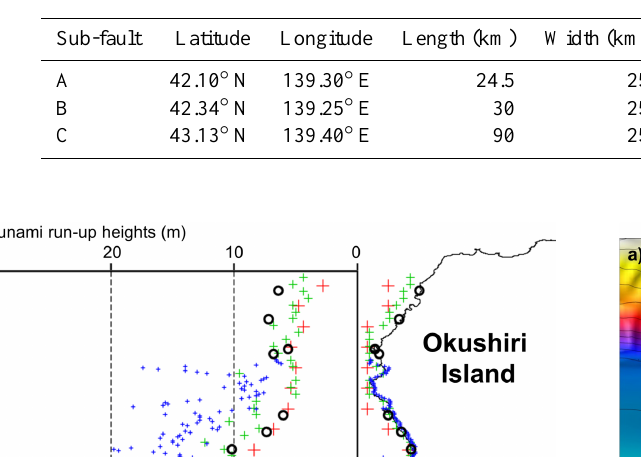
Table 2. Fault parameters of the 1993 Hokkaido–Nansei–Oki earthquake tsunami (Takahashi et al., 1995).